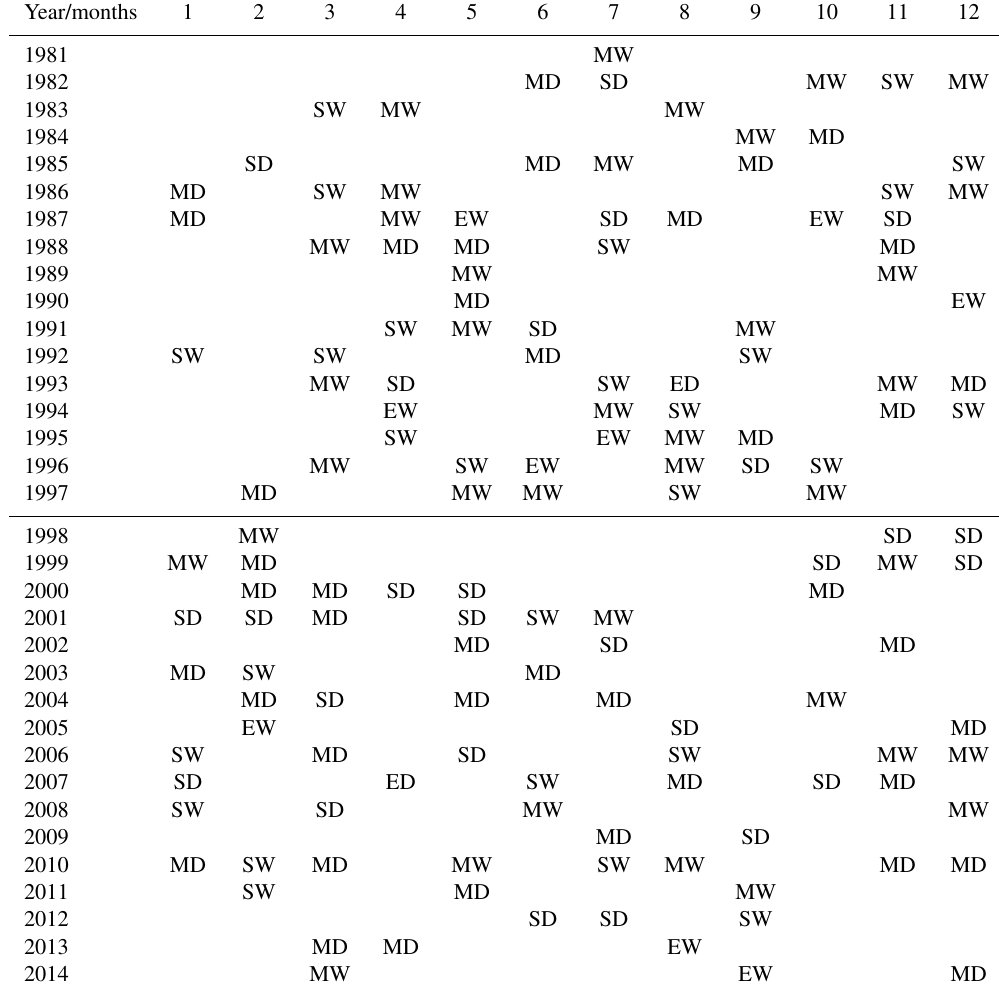
Table 2. Temporal variations in monthly SPEI over UJB from 1981–2014. The blank cells show normal months, and the different severity levels are presented as EW – extremely wet; ED – extremely dry; SW – severely wet; SD –severely dry; MW – moderately wet; and MD – moderately dry). The line between 1997 and 1998 indicates the strong change in the basin climatic